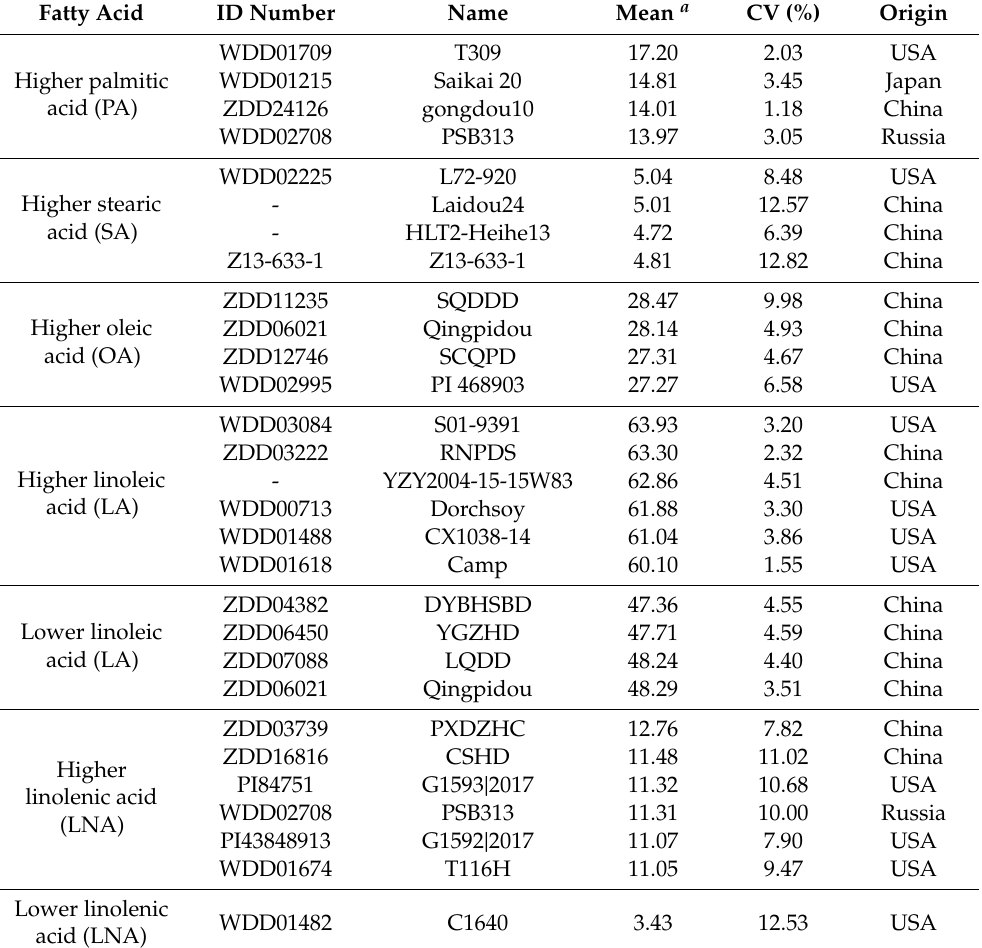
Table 4. Accessions showing desired contents of five fatty acids with higher stability (lower